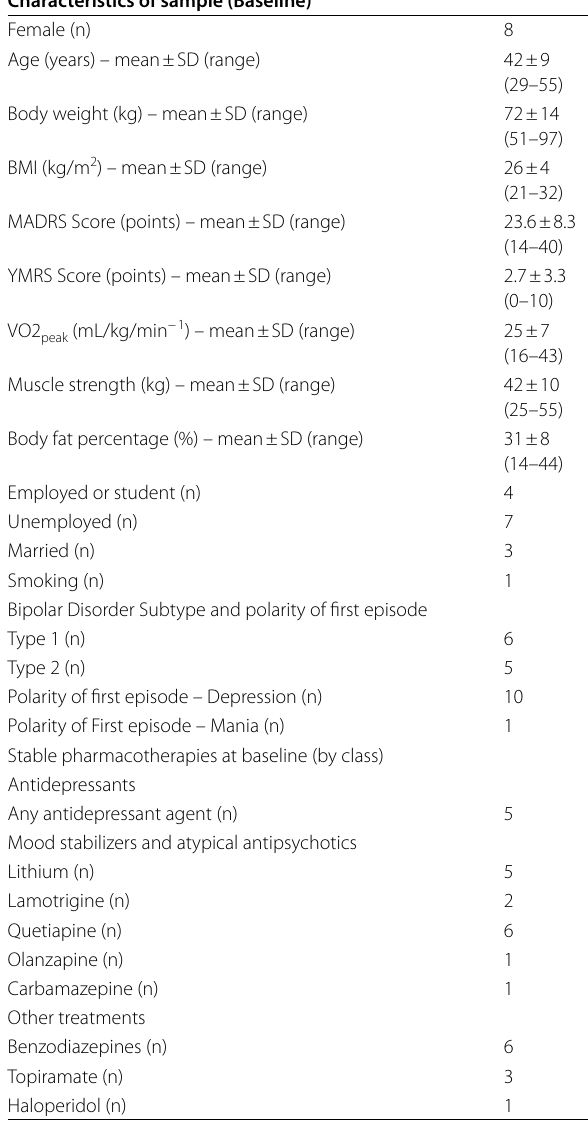
Table 1 Demographic, clinical characteristics, and pharmacological treatment at baseline (n = 11) Characteristics of sample